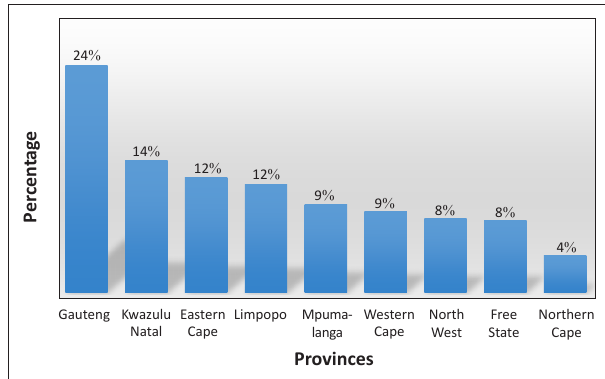
FIGURE 4: Respondents geographical